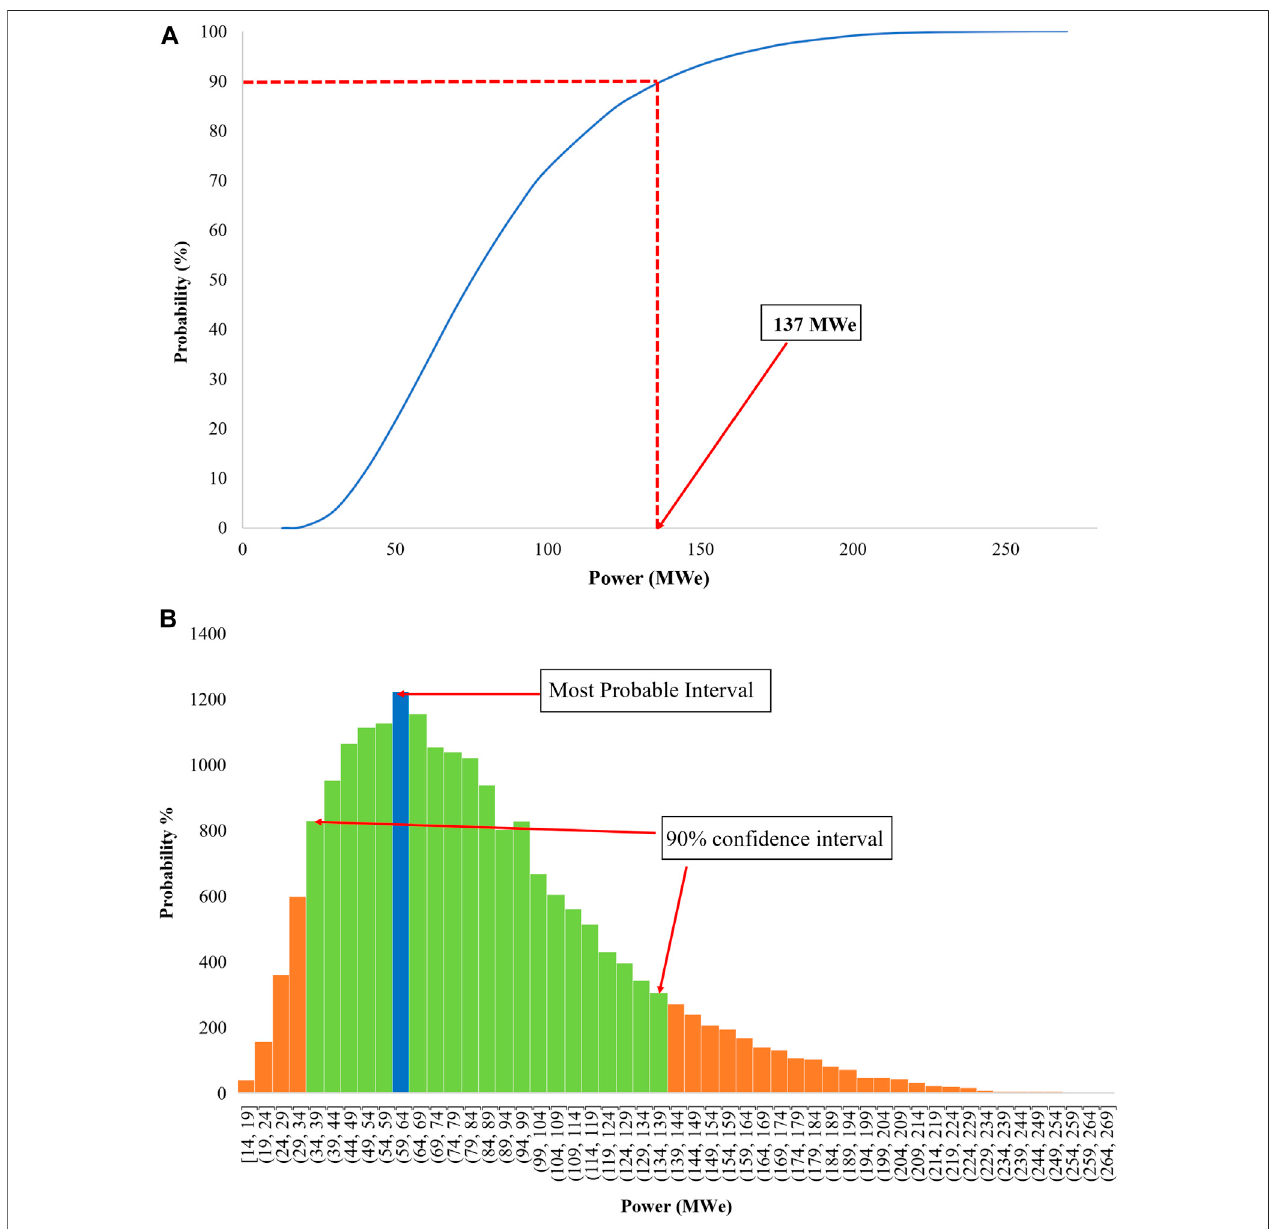
FIGURE 9 | Monte Carlo probability distribution analyses for electrical power production (MWe) for SVG02, (A) volumetric cumulative and (B) frequency.